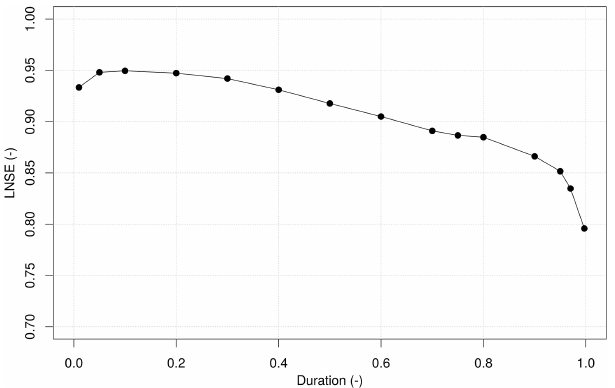
Figure 5. Cross-validation (LOOCV) of predicted dimensional FDCs. LNSE values are reported as a function of